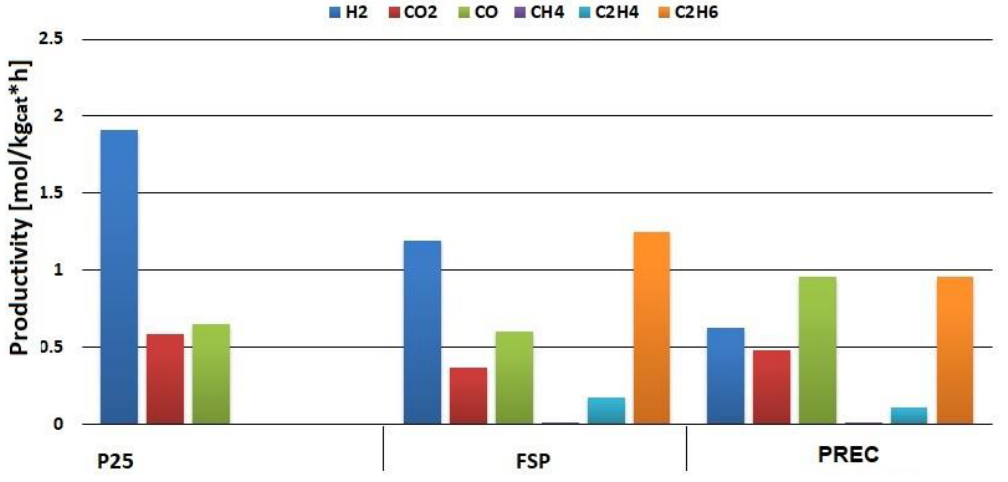
Figure 8. Productivity of gas products of three different bare titania in the photoreforming (PR) of glucose.